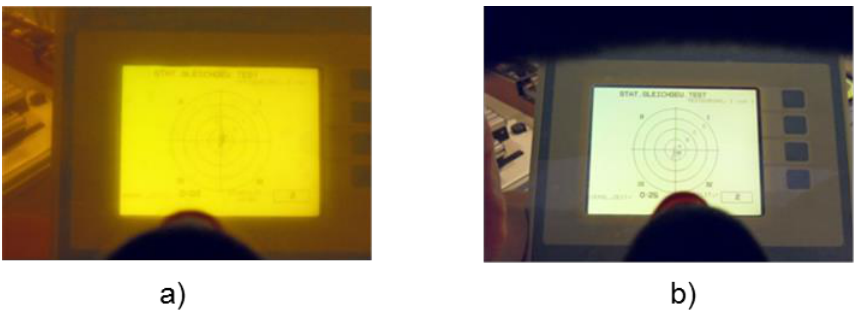
Figure 1. View on the visual feedback of the test device with ( a ) and without ( b ) occlusion foil.